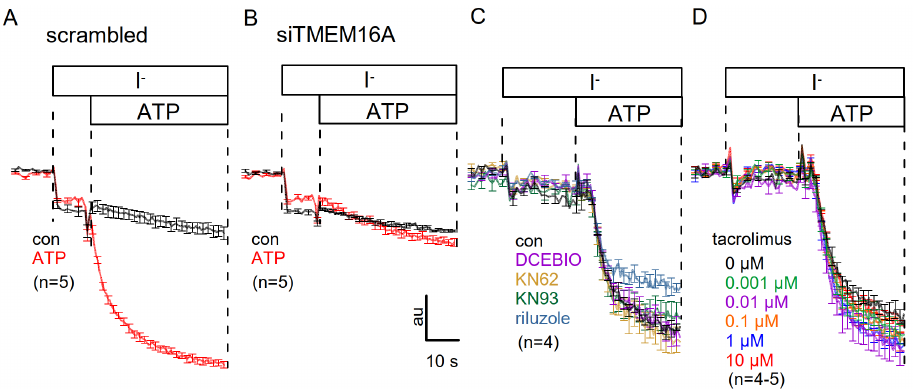
Figure 7. No evidence for CAM, CAMKII, or calcineurin-dependent regulation of endogenous TMEM16A in HT 29 colonic epithelial cells. Iodide quenching of YFP stably expressed in HT 29 colonic epithelial cells was used to assess 5 µ M ATP-activated halide permeability by activation of TMEM16A. ( A ) ATP-induced quenching in mock transfected HT 29 cells. ( B ) ATP-induced quenching in HT 29 cells with siRNA-knockdown of TMEM16A. ( C ) Preincubation of the cells with DCEBIO, KN-62, KN-93, and riluzole (all 10 µ M) did not affect ATP-induced quenching. ( D ) Incubation with different concentrations of tacrolimus did not affect ATP-induced quenching. All experiments were performed in the presence of TRAM-34. Mean ± SEM (n = number of experiments). au = arbitrary units for fluorescence quenching.